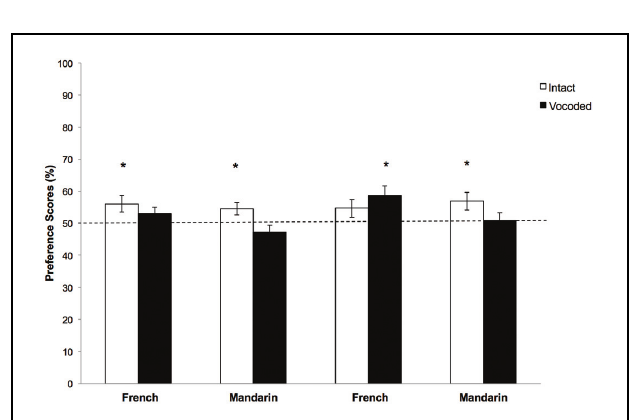
(characteristic frequency = 6113 Hz). For each stimulus, modulation excitation patterns were computed for the first (thin lines) and last (thick lines) 300-ms time period of the stimulus to highlight (dynamic) changes in AM cues over time. The modulation excitation patterns shown here were obtained by averaging the modulation excitation patterns of the eight utterances for each stimulus category.